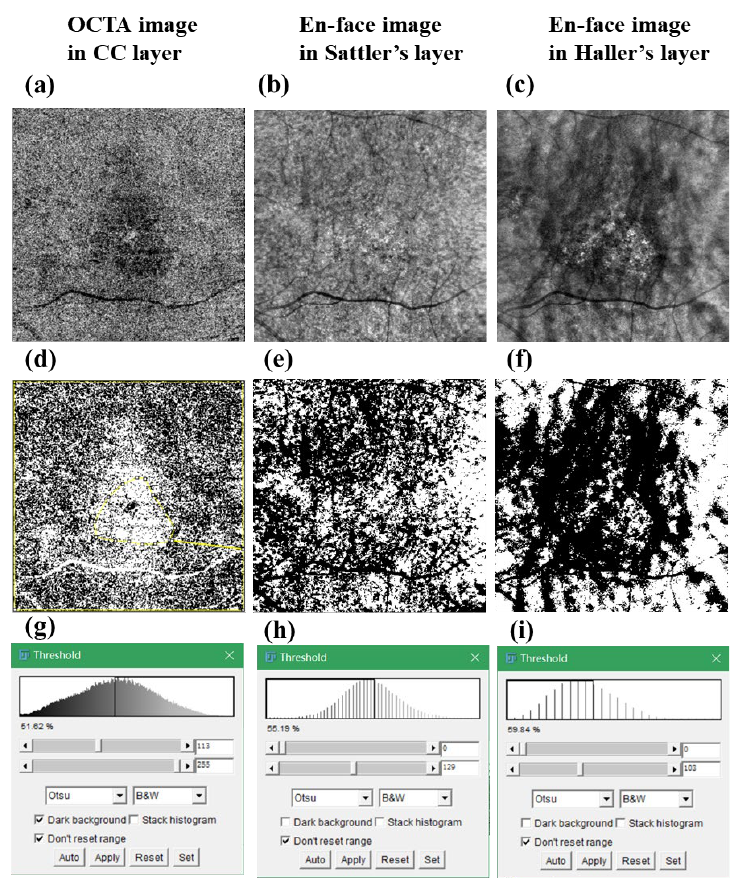
Figure 1. Representative images of an eye with CSC to describe the process for the determination of vessel density in different choroid layers using image J. ( a – c ) OCTA image in CC layer ( a ), En face images in Sattler’s ( b ), and Haller’s layers ( c ), respectively. ( d – f ) Binarized images corresponding with ( a – c ), ( g – i ); the VD was automatically calculated by image J software with the Otsu method. CC: choriocapillaris; VD: vessel density.